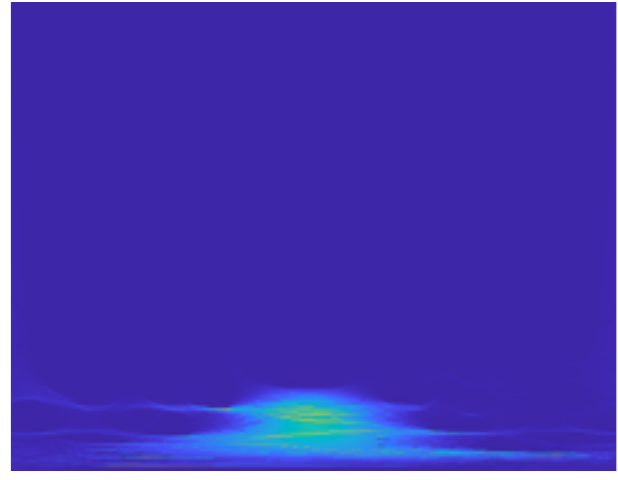
Figure 9. Time – frequency representation by